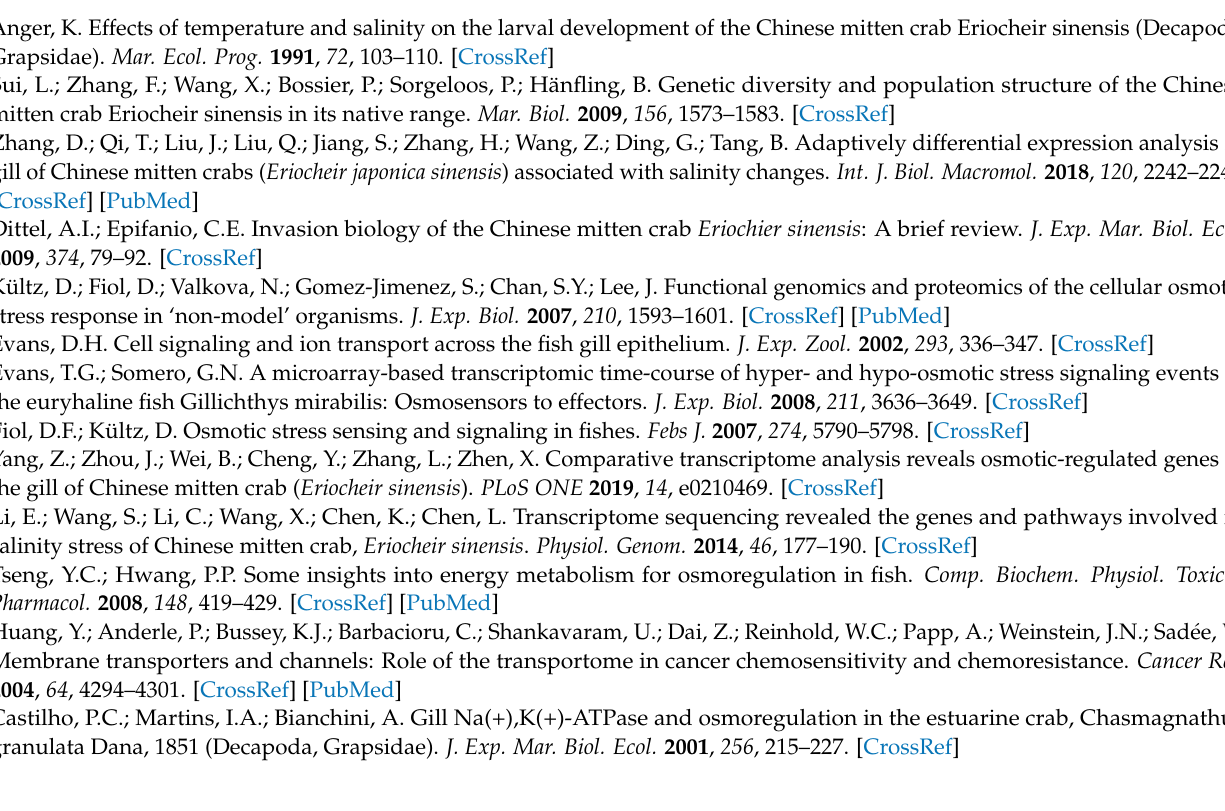
STRING-predicted (diamonds) genes, respectively. Nodes in purple indicate the hub genes labeled with orange text. Table S1: Assembly statistics of each dataset. Table S2: List of additional DETs identified by the meta-analysis. ( ↓ ) indicates that the representative transcript is downregulated. Table S3: List of DETs (2-Fold change) identified by the RNA-Seq meta-analysis. Annotations for each transcript are based on the BLASTp analysis against the UniProt database. Direction of the arrow represents whether the representative transcript is downregulated ( ↓ ) or upregulated ( ↑ ). Table S4: List of enriched GO categories in terms of the biological process (BP), molecular function (MF), and cellular component (CC). Table S5: Enrichment analysis of each individual cluster identified in the interaction network. Clusters with <10 nodes were excluded from the enrichment analysis. Table S6: List of DETs that were assigned to a transporter family based on the BLASTp analysis against the TCDB. Direction of the arrow represents whether the representative transcript is downregulated ( ↓ ) or upregulated ( ↑